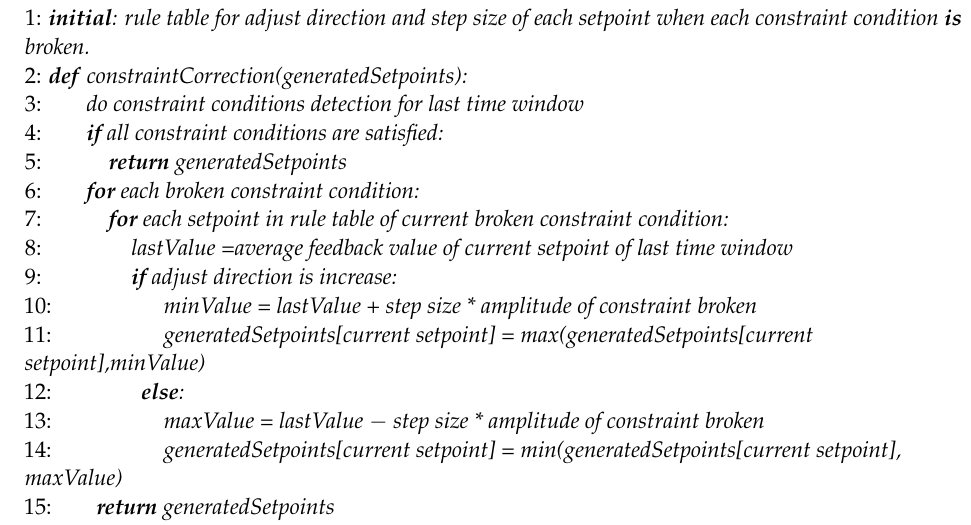
Algorithm 6: The main logic of feedback constraint correction